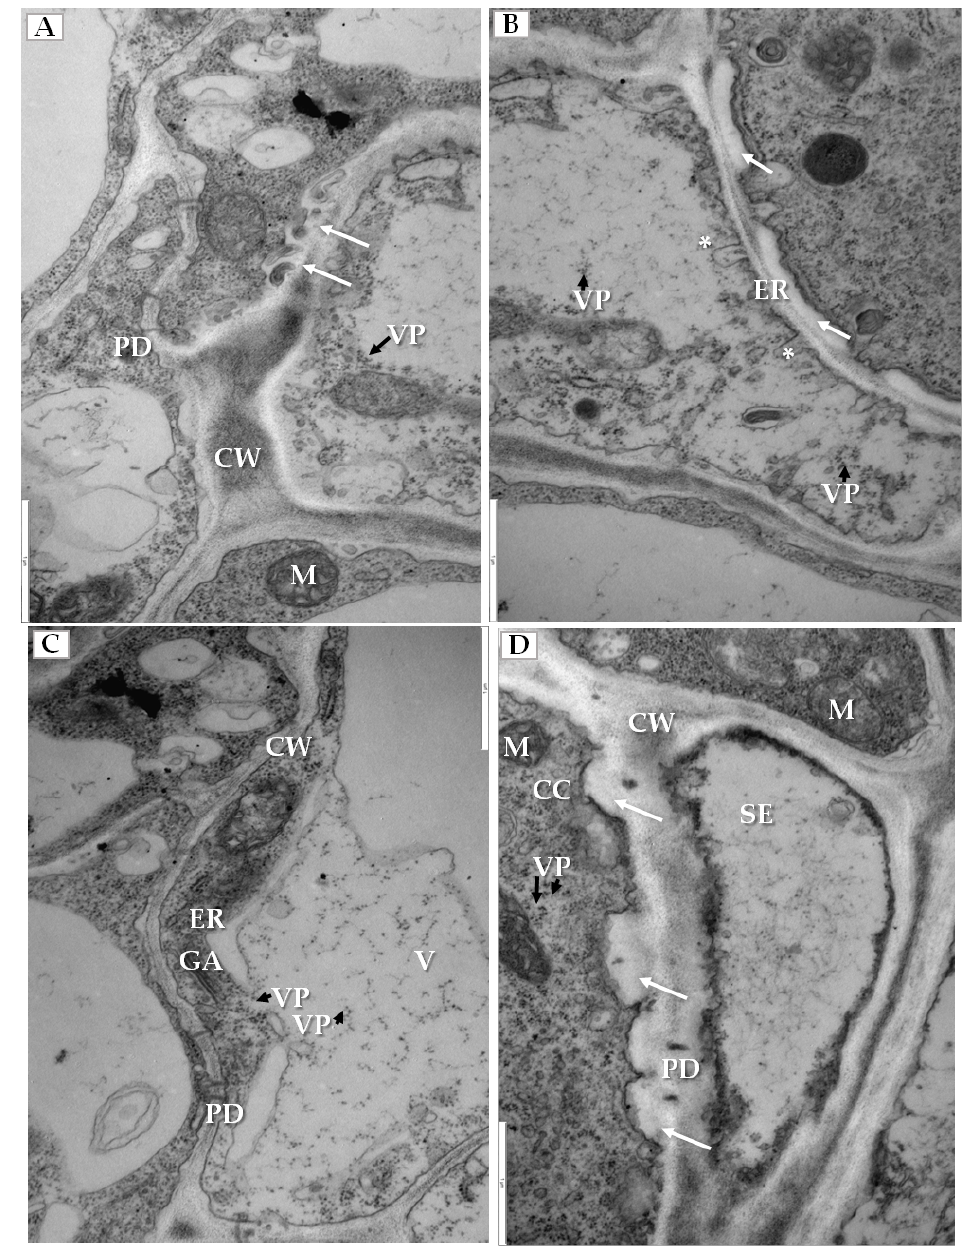
Figure 7. Changes in cell wall structure and plasmolemma in phloem cells of PDV infected cucumber leaves. ( A ) Fragment of phloem parenchyma with cell-wall invaginations (white arrow). Viral particles (VP, black arrow) in phloem parenchyma cell, Bar 1 µm; ( B ) Fragments of phloem parenchyma cells with irregular cell wall (white arrow) and plasmalemma invaginations (*) and with viral particles (VP, black arrow), Bar 1 µm; ( C ) Presence of viral particles (VP, black arrow) inside the vacuole with the vacuolar lumen having connections to the cytoplasm of parenchyma cell, Bar 1 µm; ( D ) An irregular and thicker cell wall (white arrow) between companion cell with viral particles (VP, black arrow) and sieve tube, Bar 1 µm. Abbreviations: CW—cell wall, PD—plasmodesmata, ER—endoplasmic reticulum, GA—Golgi apparatus, MT—movement protein induced tubular structures, VP, black arrow—viral particles, SE—sieve tube, CC—companion cell, M—mitochondrion, V—vacuole.